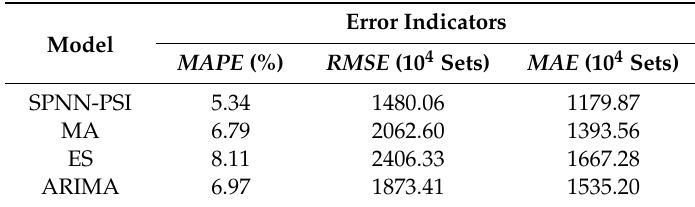
Table 2. Error indicators of each prediction model on the EME dataset.